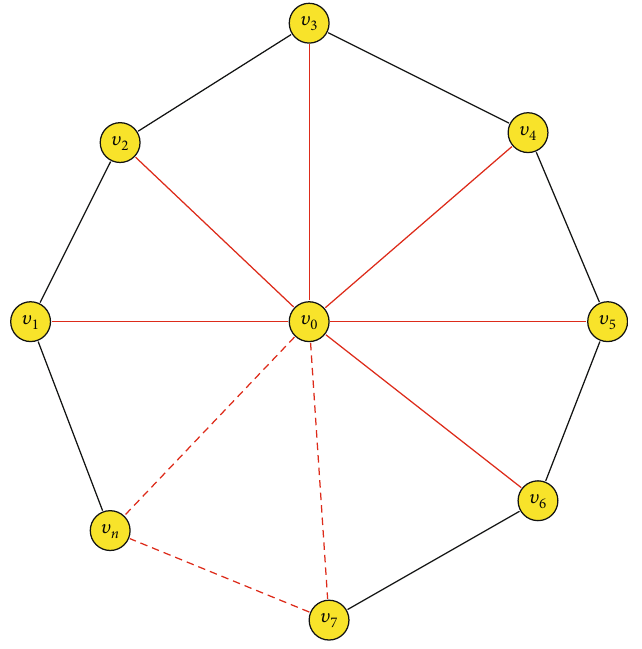
Figure 1: An image of a wheel